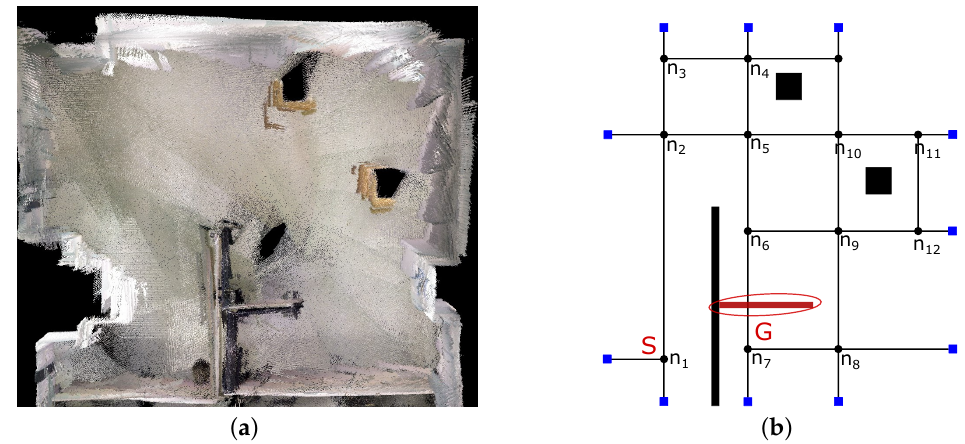
Figure 11. ( a ) RGBD map updated by P3DX. ( b ) Node-map. S and G are the start and goal points. The new obstacle is shown on nodes n 6 n 7 . Ellipse represents positional uncertainty.